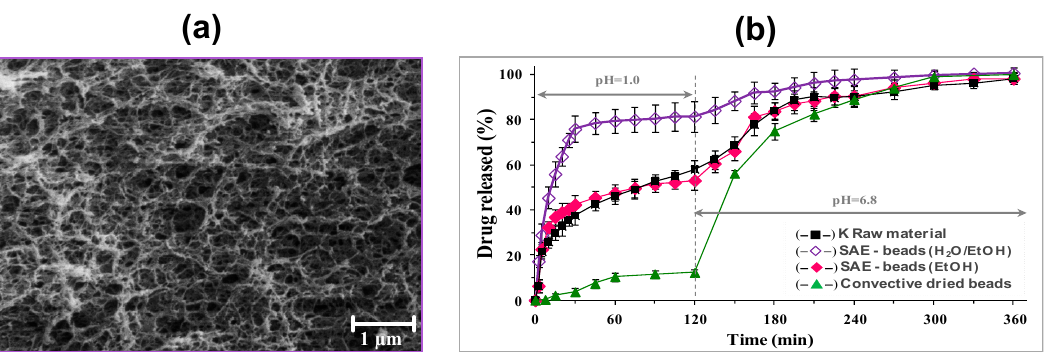
Figure 16. Main in vitro results obtained for alginate-based aerogel beads loaded with ketoprofen: ( a ) SEM microphotographs showing the inner nanoporous structure; ( b ) Release profiles of beads dried by both supercritical-CO 2 and conventional drying, performed in simulated gastro-intestinal fluids by using USP Apparatus 2. Reprinted from [208] with permission from Elsevier. Copyright